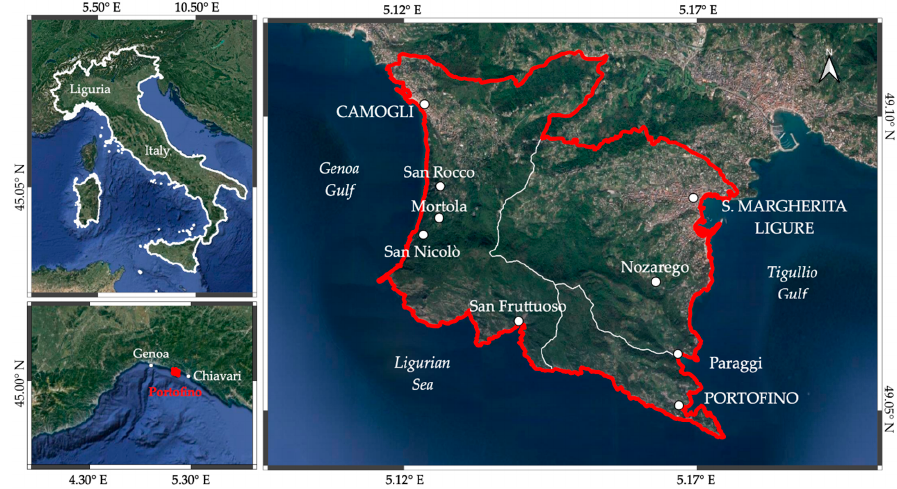
Figure 1. Location of the Portofino promontory. The red line shows the study area; white lines represent the boundaries of the three municipalities.